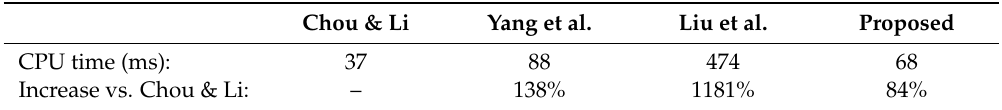
Table 5. CPU time used by MATLAB implementations of different JND models for evaluating the JND profile of the BARB test image.